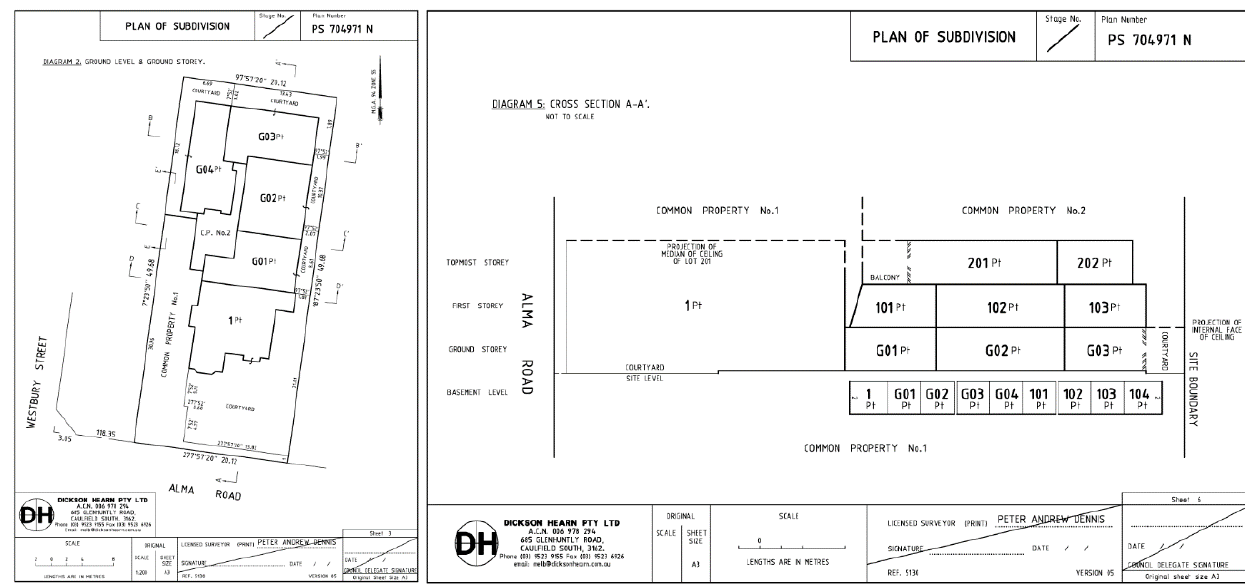
Figure 1. sample of a building subdivision plan including floor plans and